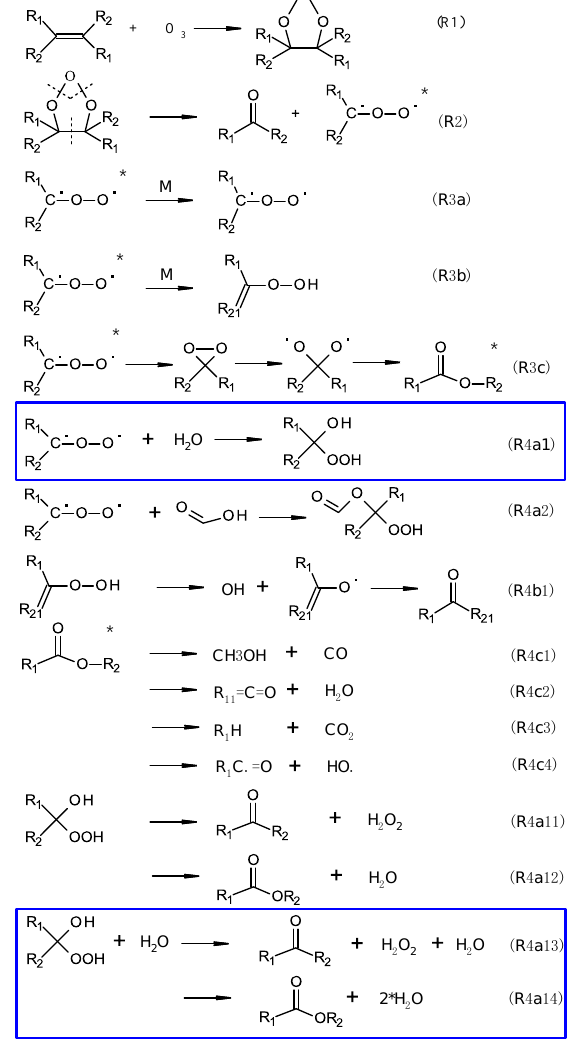
Scheme 1. The major steps for the ozonolysis of alkenes in the gas phase. The reactions in the blue box are related to the water effect on the formation and removal of HAHPs.